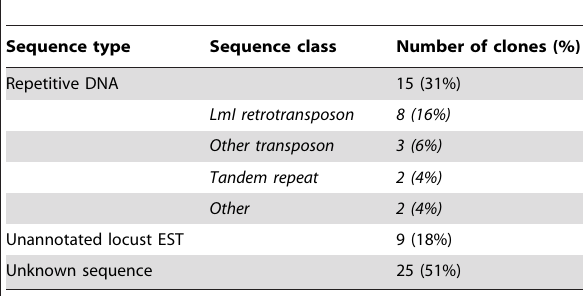
Table 1. Identity of cloned DNA sequences derived from methyl-CpG enriched portion of the L. migratoria